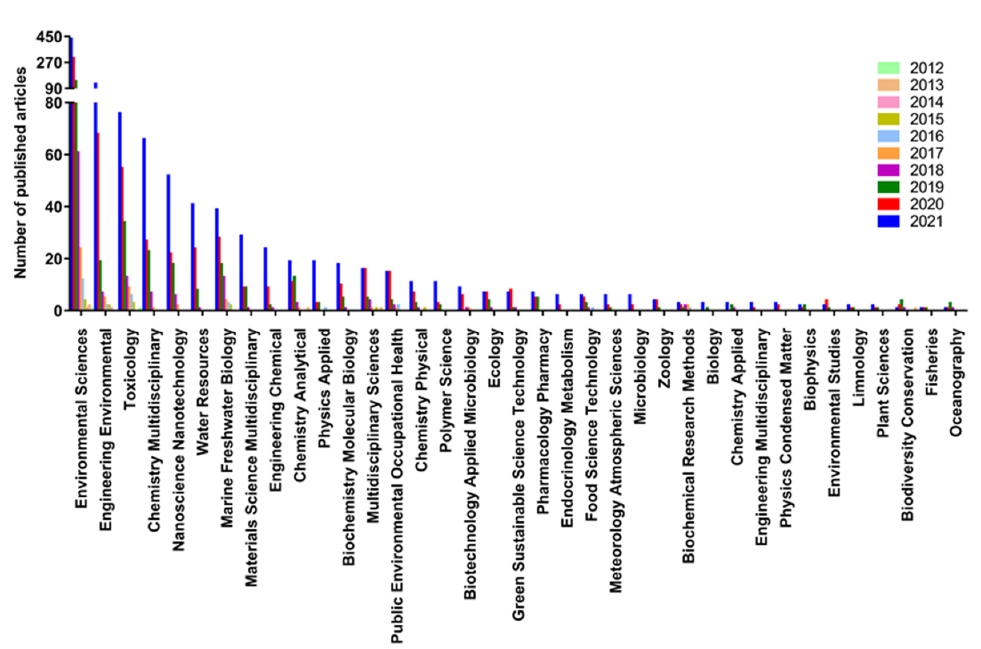
Figure 2. Number of published articles in different Web of Science categories in last 10 years (2012–2021) found using the search keywords “NANOPLASTICS OR MICROPLASTICS AND TOXICITY AND AQUATIC” in all fields. This analysis was performed on 31 January 2022.